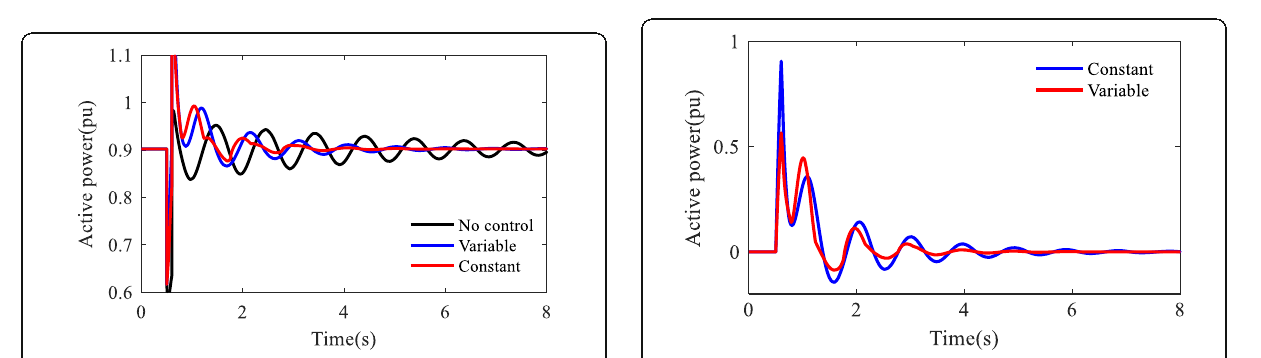
Fig. 10 The active power output of the PV-VSG when the output power of the PV is 0.9 pu